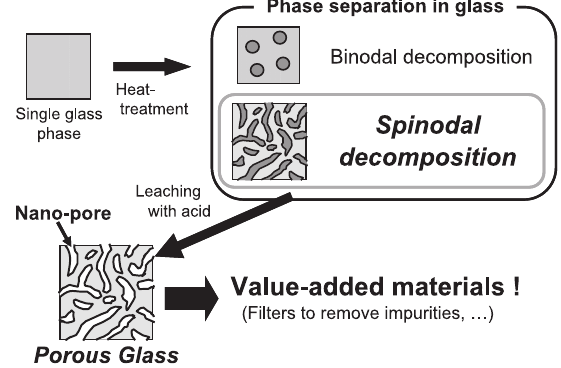
Fig. 1: Schematic diagram to create porous glass using phase separation in glass obtained from